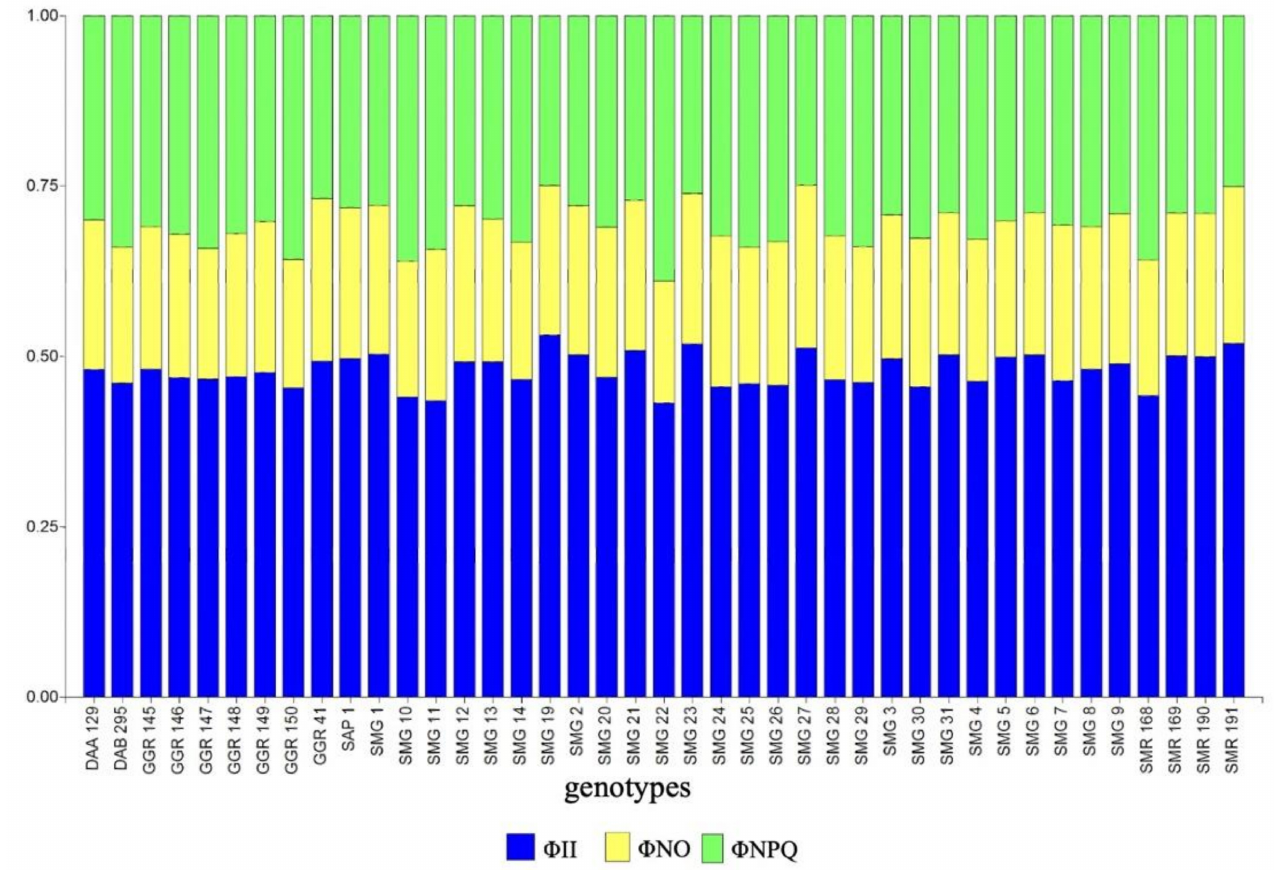
Figure 3. Genotypic differences in energy allocation proportions. Each bar represents the unit, and it is split into three parts in terms of the complementary quantum yields of PSII: Φ II: quantum yield of photochemical energy conversion in PSII, Φ NO: quantum yield of non-regulated non-photochemical energy loss in PSII, and Φ NPQ: quantum yield of regulated non-photochemical energy loss in PSII ( Φ